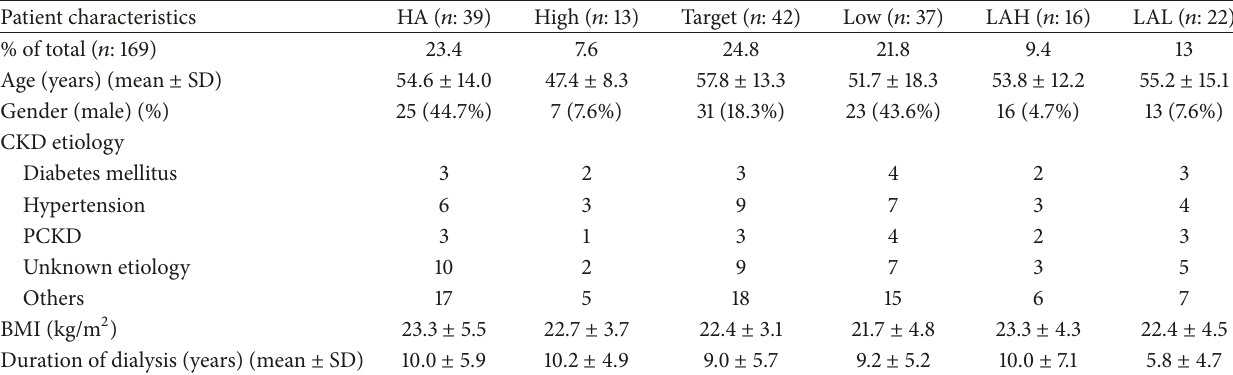
Table 1: Patient characteristics of hemoglobin variability.